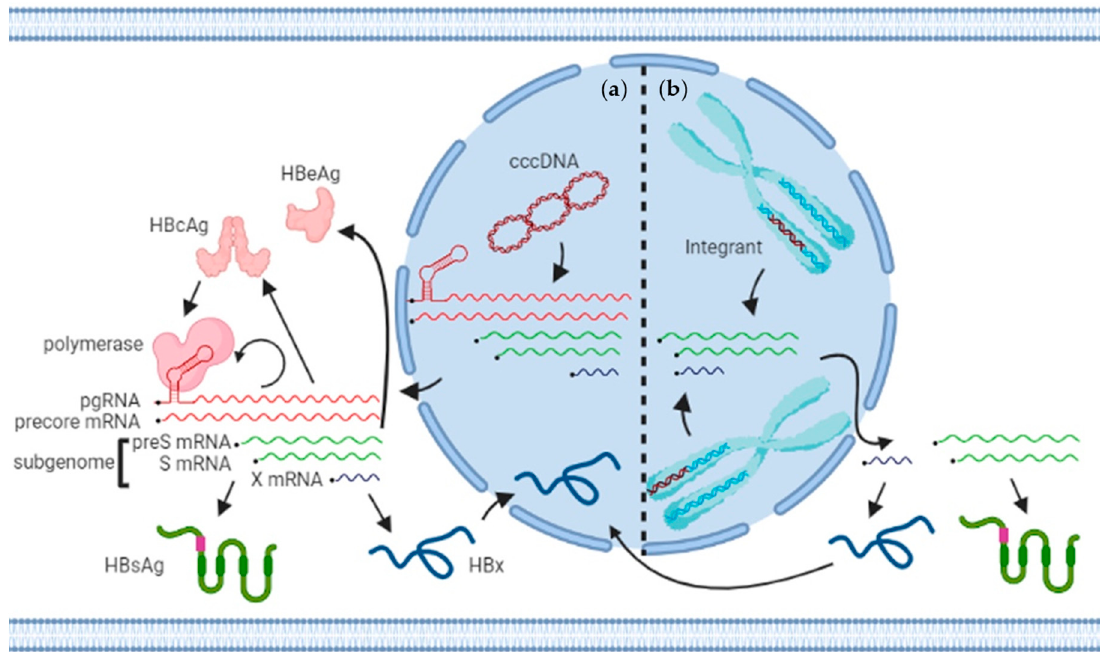
Figure 1. Overview of HBV transcription and translation from cccDNA and genomic integrants. ( a ) In the nucleus where cccDNA resides, RNA polymerase II-mediated transcription from cccDNA generates five capped and polyadenylated transcripts: pgRNA (3.5 kb), precore mRNA (3.5 kb), preS mRNA (2.4 kb), S mRNA (2.1 kb), and X mRNA (0.7 kb), all of which are exported into the cytoplasm. Seven viral proteins are translated from those transcripts (see text for details). ( b ) HBV subgenomic fragments are randomly integrated into different chromosomal locations. PreS/S and probably X transcripts are generated from integrated genomes and translated to HBsAg and HBx. So far, no evidence has emerged that pgRNA and precore mRNA can also be produced in this manner. HBx is imported in the nucleus and functions as a transactivator on cccDNA.